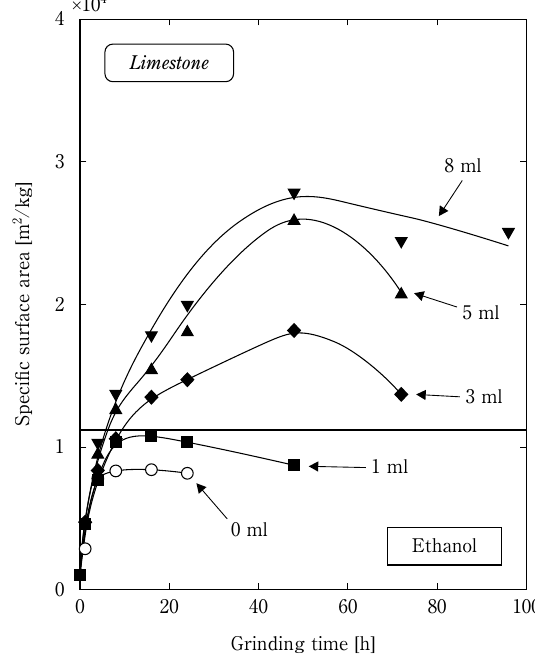
Fig. 3 Variations of specific surface area of limestone as a function of grinding time with the addition amount of